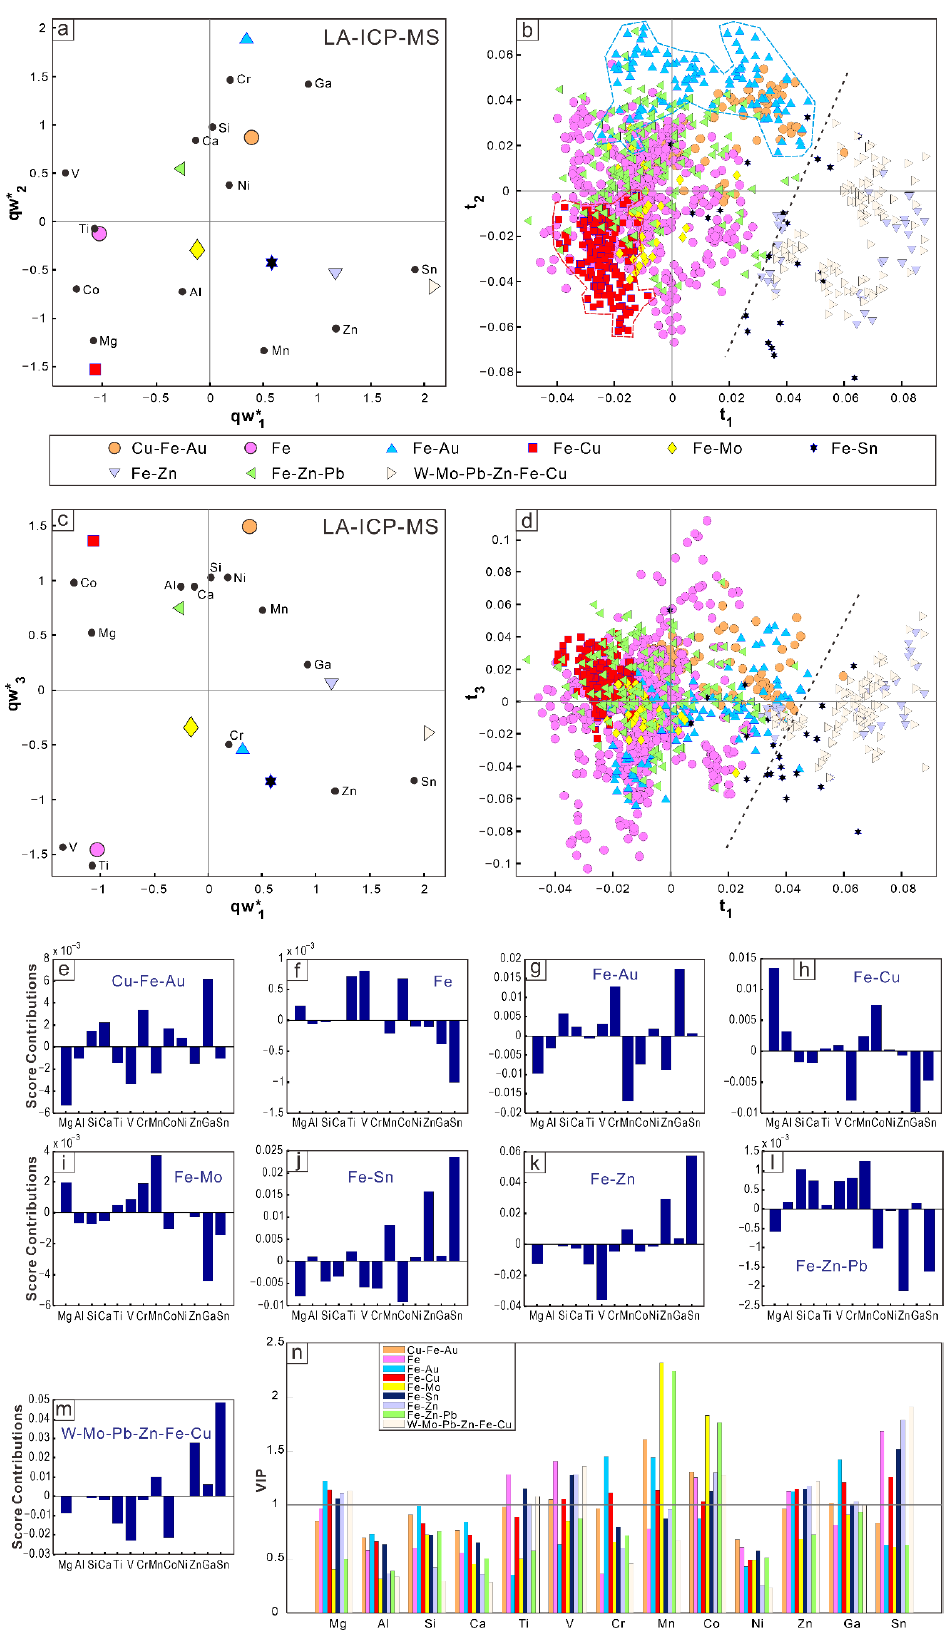
Figure 6. The PLS-DA results of LA-ICP-MS data of magnetite. ( a ) The first and second loading plots show correlations among the element variables and mineralization types. ( b ) The first and second score plots show the distribution of individual analyses of magnetite in the latent variable space defined by qw* 1 -qw* 2 in ( a ). ( c ) The first and third loading plots show correlations among the ele- ment variables and mineralization types. ( d ) The first and third score plots show the distribution of individual analyses of magnetite in the latent variable space defined by qw* 1 -qw* 3 in ( c ). ( e – m ) Score contribution plots for different mineralization types of skarn deposits. ( n ) Important projection plot variance for the elements. The gray line represents the VIP value of 1.